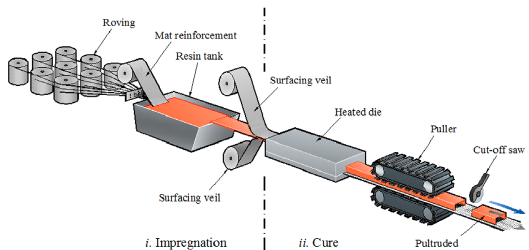
Figure 2. Pultrusion process of Glass Fiber Reinforced